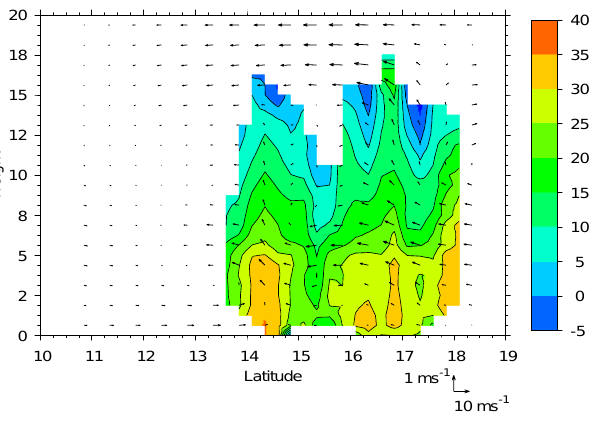
Fig. 12. Results of the synthesis using radar data only. A vertical cross section at longitude 140 . 5 ◦ is displayed. The arrows show the projection of the Earth-relative wind field, while colors and contours show the reflectivity field. The scales for the meridional and vertical winds are indicated at the bottom of the plot. Contours are shown every 5 dbz.